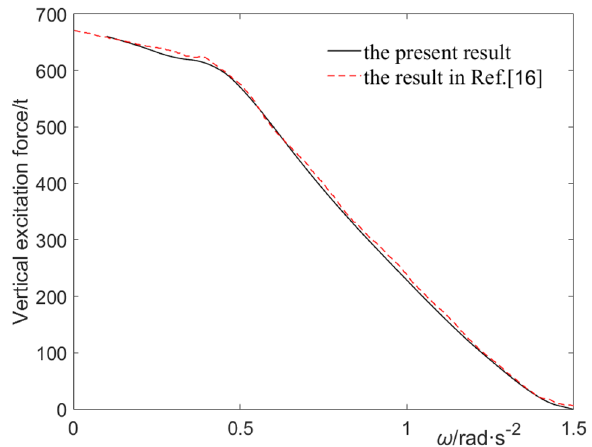
Fig. 5 Influence of wave frequency on the vertical force for the 4th pontoon ( 𝛽 = 45 ◦ )